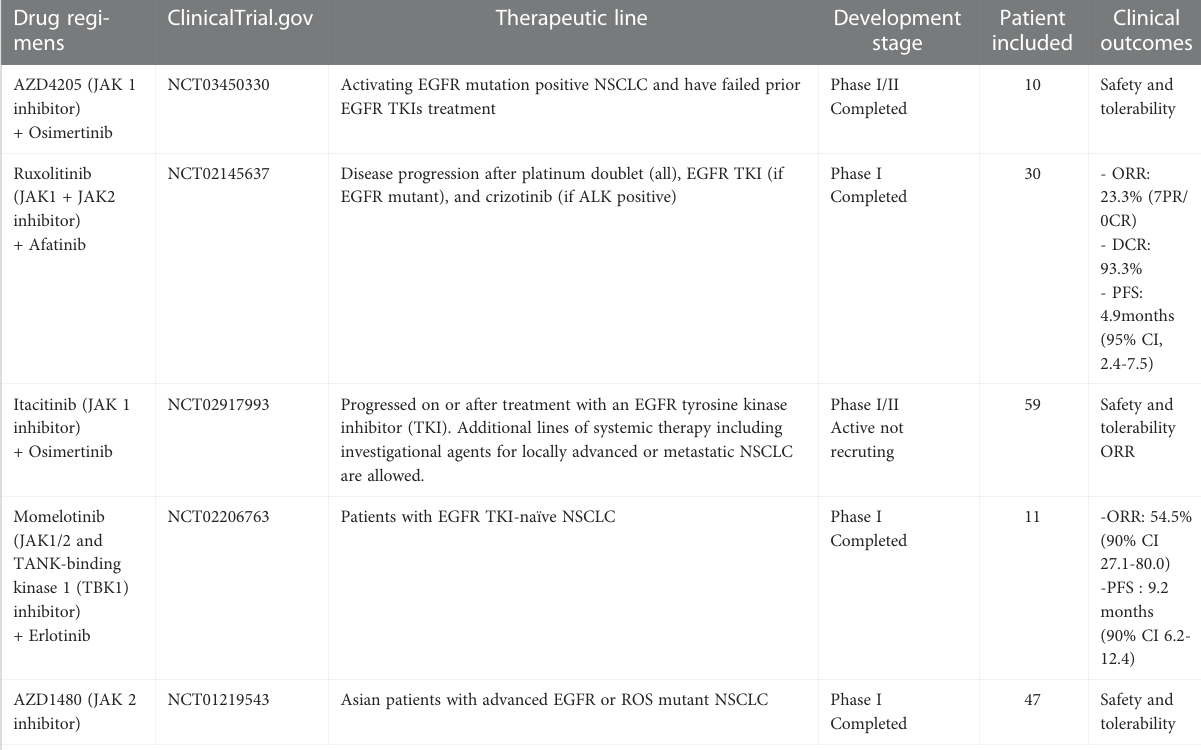
TABLE 1 Published and ongoing trial evaluating inhibitors of JAK/STAT pathway for EGFR-mutated non-small cell lung cancer. Drug regi- ClinicalTrial.gov mens